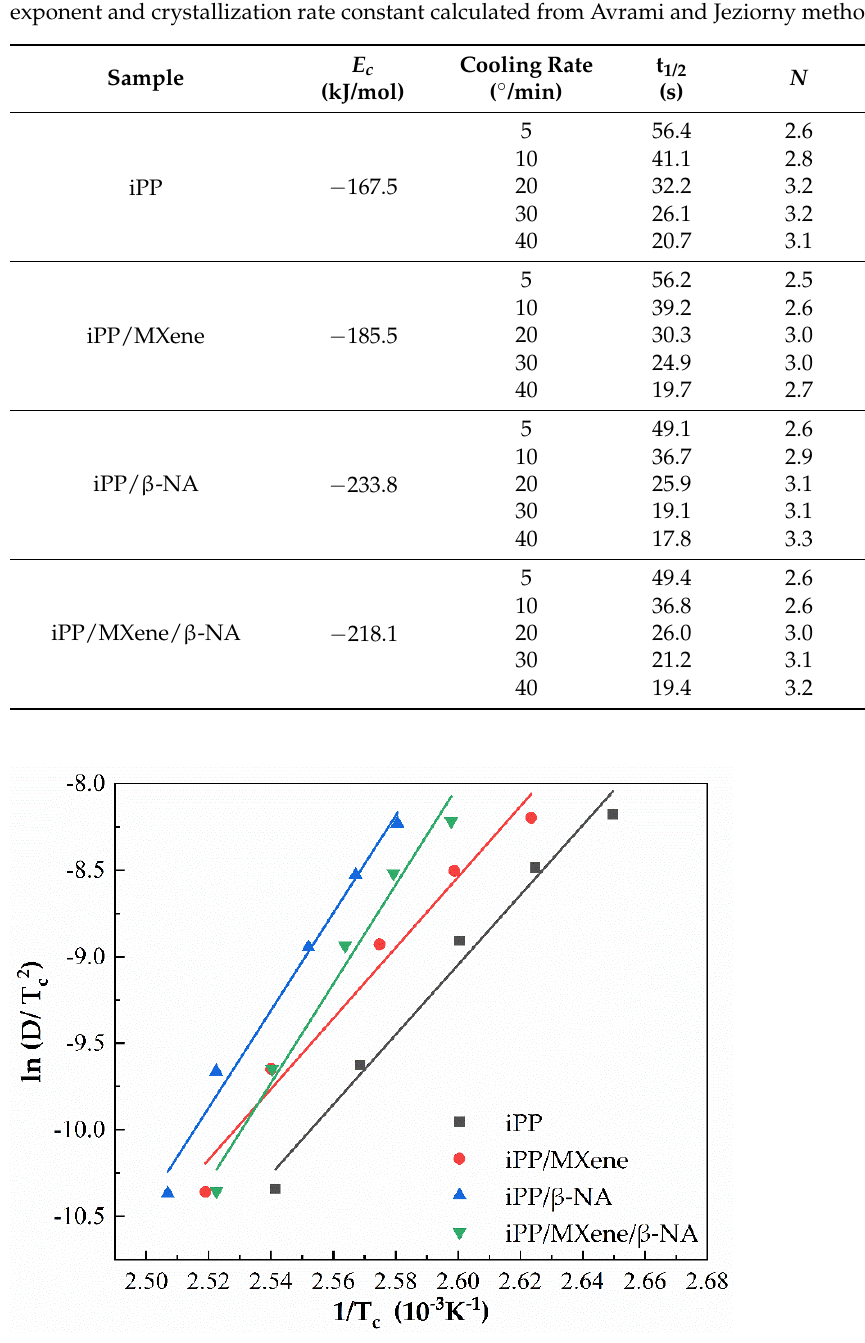
Figure 8. Plots of ln(D/T c2 ) versus 1/T c of four samples to calculate nonisothermal activation energy E c by Kissinger method. E c by Kissinger